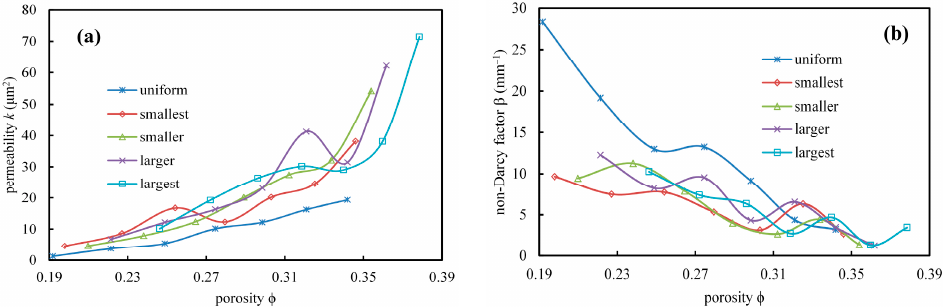
Figure 14. Comparison of non-Darcy flow characteristics of the five samples: ( a ) k - ϕ curves; and ( b ) β - ϕ curves.